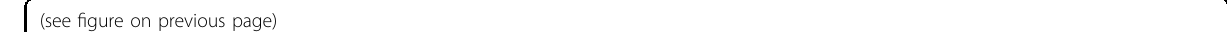
Fig. 2 Cooperative antileukemic activity of CUDC-907 plus gilteritinib demonstrated in vitro and in vivo. A FLT3-ITD AML cell lines MOLM-13 and MV4-11 were treated with or without CUDC-907, after 12 h gilteritinib was introduced to the indicated samples, for a total CUDC-907 treatment duration of 24 h. Samples were then stained using annexin V/PI, and analysis performed via fl ow cytometry. Representative experiments are displayed, with combination index (CI) calculated using CompuSyn software. ***p < 0.001 compared to single-drug treatments. Individual CI values are shown in Supplementary Table S4. B FLT3-ITD AML cell lines MOLM-13 and MV4-11 were treated with gilteritinib, CUDC-907, both, or neither, for 24 h concurrently, and then annexin V/PI staining and fl ow cytometry analysis were performed. Representative results from one experiment are displayed. C MOLM-13 and MV4-11 cells were treated with gilteritinib, CUDC-907, both, or neither, for 24 h concurrently, and then whole-cell lysates underwent western blot analysis of cleaved-caspase 3 (cf-caspase 3) and β -actin. D MV4-11 cells were treated with stepwise increasing concentrations of cytarabine to generate MV4-11 cells with acquired cytarabine resistance (designated MV4-11/AraC-R). MV4-11/AraC-R cells were cultured in the presence or absence of the AraC concentration used to maintain resistance (1100 nM) for 5 days. Then the AraC resistant cells and parental cells were treated with variable concentrations of AraC for 72 h. Viable cells were determined using the MTT assay. Representative curves are shown on the left. IC50s were calculated and are presented on the right. *** p < 0.001 compared to the parental cells. MV4-11/AraC-R cells were treated with vehicle control, CUDC-907, gilteritinib, or in combination for 24 h. Cells were stained with annexin V/PI and subjected to fl ow cytometry analyses. CI values were calculated using CompuSyn software. Individual CI values are shown in Supplementary Table S4. *** p < 0.001 compared to control and single-drug treatment. E Western blots of FLT3 were generated utilizing whole-cell lysates from AML cell lines MOLM-13, MV4-11, OCI- AML3, and THP-1. Densitometry results compared to MOLM-13 and normalized to β -actin are shown. F OCI-AML3 and THP-1 cells were treated with CUDC-907 for 24 h. Whole-cell lysates were subjected to western blotting. Densitometry results for FLT3 compared to vehicle control and normalized to β -actin are shown. G The FLT3-wt AML cell lines THP-1 and OCI-AML3 were treated with CUDC-907, gilteritinib, both, or neither, for 24 h concurrently, and then underwent annexin V/PI staining and fl ow cytometry analysis. CI values were calculated using CompuSyn software. Individual CI values are shown in Supplementary Table S4. * p < 0.05, ** p < 0.01, and *** p < 0.001 compared to single-drug treatment. H , I NSGS mice were injected with 1 × 10 6 MV4-11 cells/mouse via the tail vein on day 0. Mice were then randomized to one of four treatment groups: vehicle control (3% 200 proof ethanol, 1% polyoxyethylene sorbitan monooleate, and USP water; n = 5), CUDC-907 (100mg/kg; n = 5), gilteritinib (40 mg/kg; n = 5),